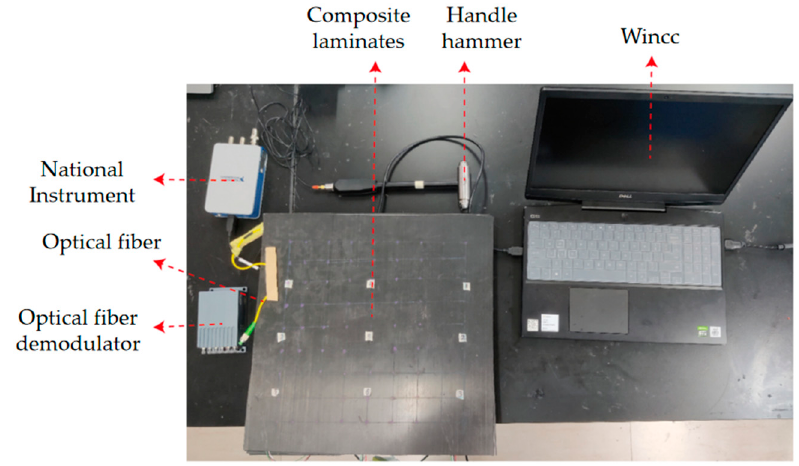
Figure 9. Construction of the experimental system.